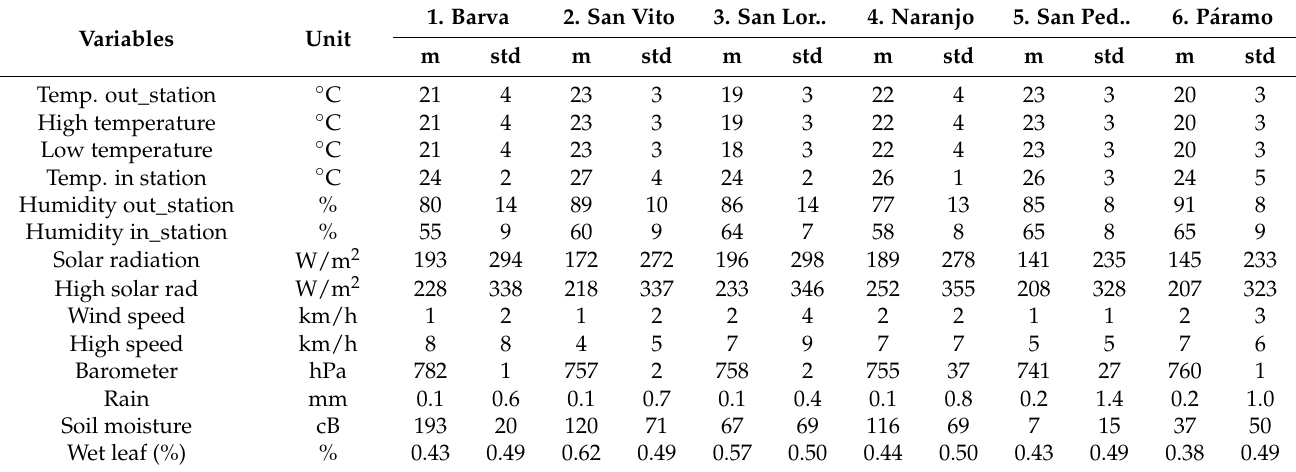
Table 1. Mean and standard deviation of the